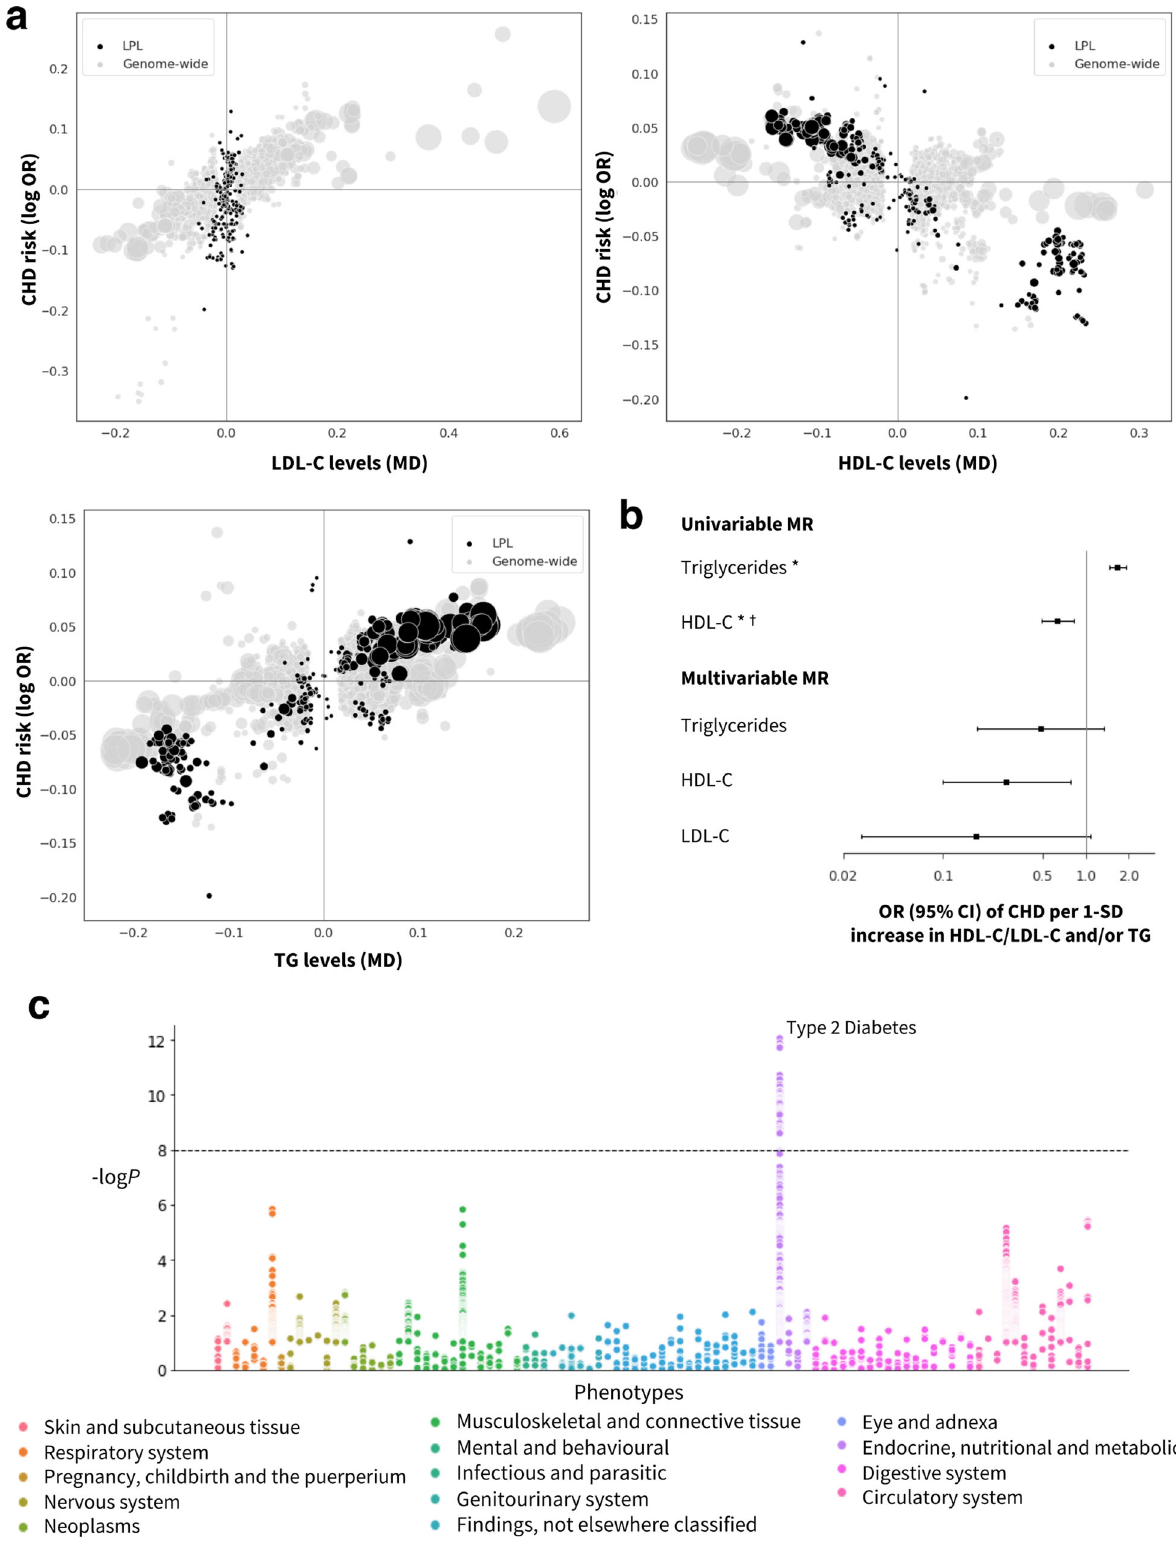
Fig. 4 Prioritized target: lipoprotein lipase (LPL). a Genetic associations at the locus (±50kbp) in black vs. genome-wide associations (gray, P value<1×10 − 6 based on two-sided z -tests). The x -axis shows the per allele effect on the corresponding lipid expressed as mean difference (MD) from GLGC and the y-axis indicates the per allele effect on CHD expressed as log odds ratios (OR) from CardiogramPlusC4D. The marker size indicates the signi fi cance of the association with the lipid sub-fraction ( P value). b Univariable and multivariable (drug target) cis -MR results presented as OR and 95% con fi dence intervals with lipid exposure ( n = 188,577 individuals) and CHD outcome ( n = 60,801 cases and 123,504 controls). An asterisk (*) indicates the MR estimates as being replicated, and a dagger ( † ) that the lipid effect and CHD signals are co-localized. c . Disease associations at the locus with 103 clinical endpoints from UK Biobank and GWAS